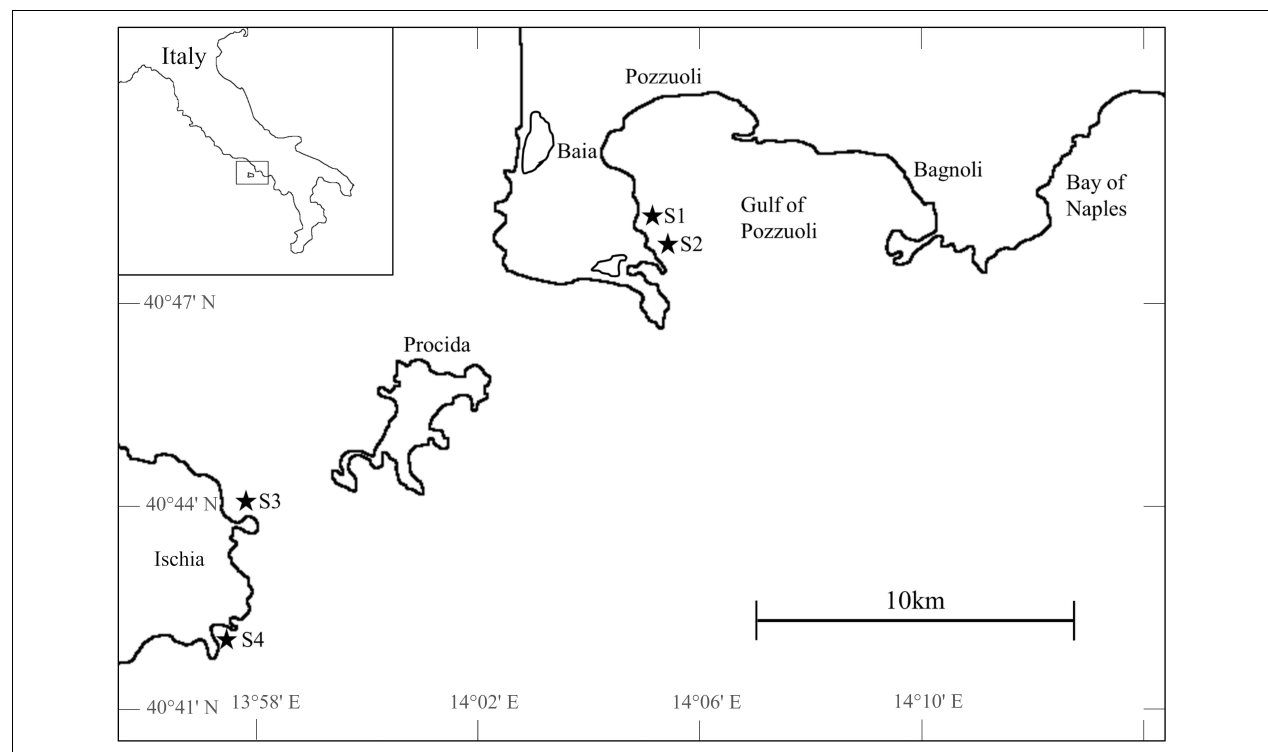
FIGURE 1 | Study sites in the urbanized Gulf of Pozzuoli (S1, S2) and in the Marine Protected Area “Regno di Nettuno” off the island of Ischia (S3,